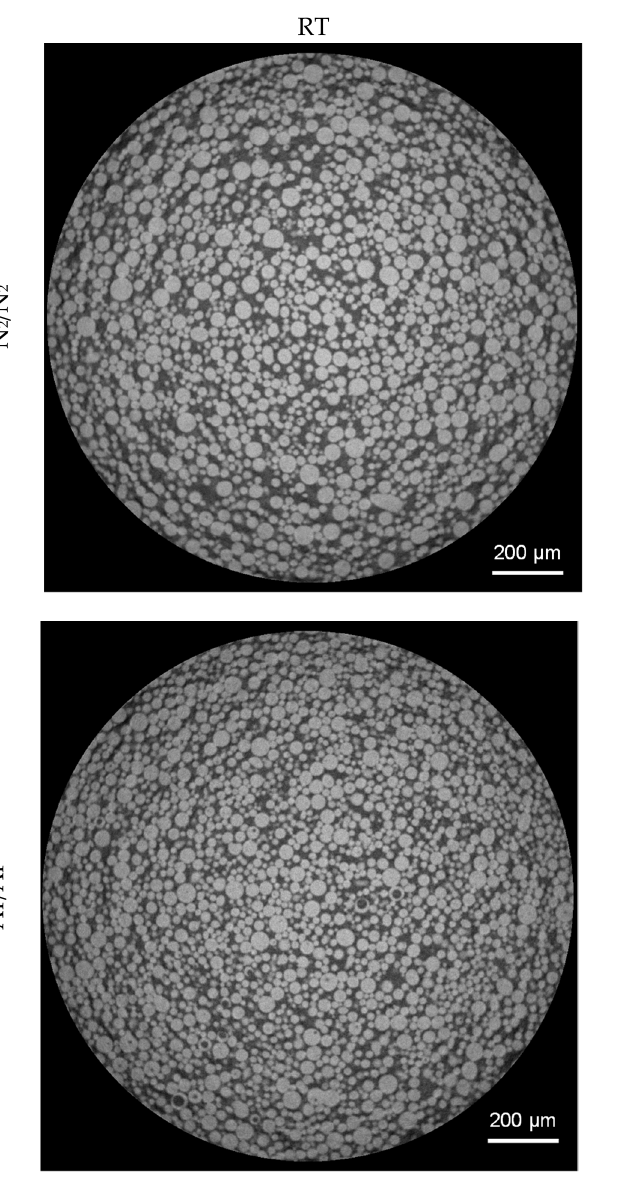
Figure 6. Light micrograph of gas-atomized X2CrNiMoCuWN25-7-4 powders (particle size 20–63 µm, polished sections).